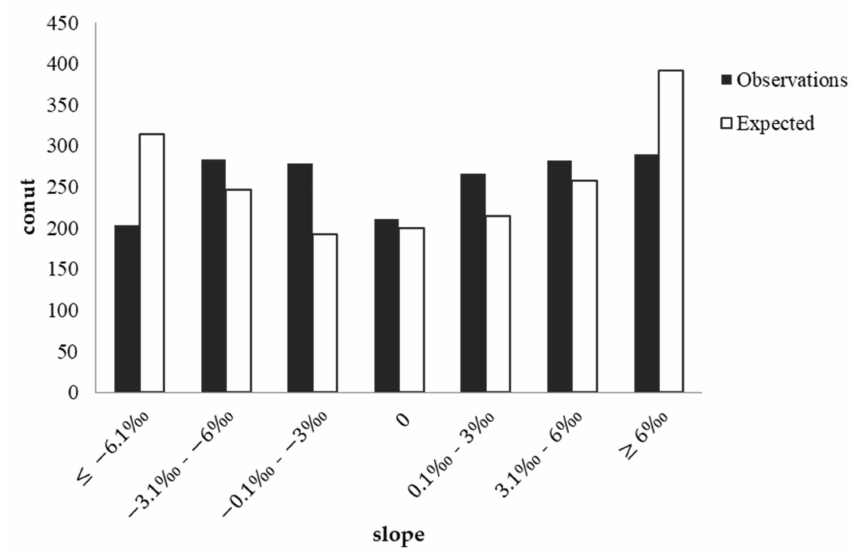
Figure 3. Plot of observed and expected collision occurrence at different slopes. Table 3. Classification of precrash